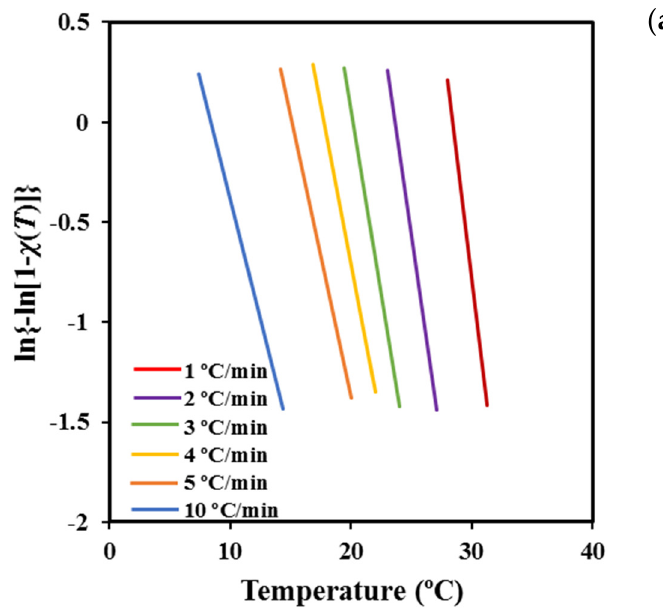
Figure 7. Plots of ln{ − ln[1 − χ ( T )]} against temperature for non-isothermal crystallization of P4HB with cooling rates as a parameter ( a ). Determination of the Avrami exponent using linear plots of T p ′ against (ln φ )/a ′ ( b ). Table 3. Characteristic crystallization parameters obtained for P4HB by using the methodology developed by Cazé et al. [30]. φ ( °C